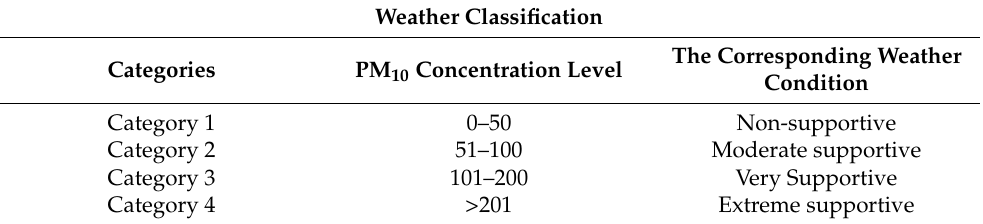
Table 1. The relationship classification between atmospheric meteorological variables and PM 10